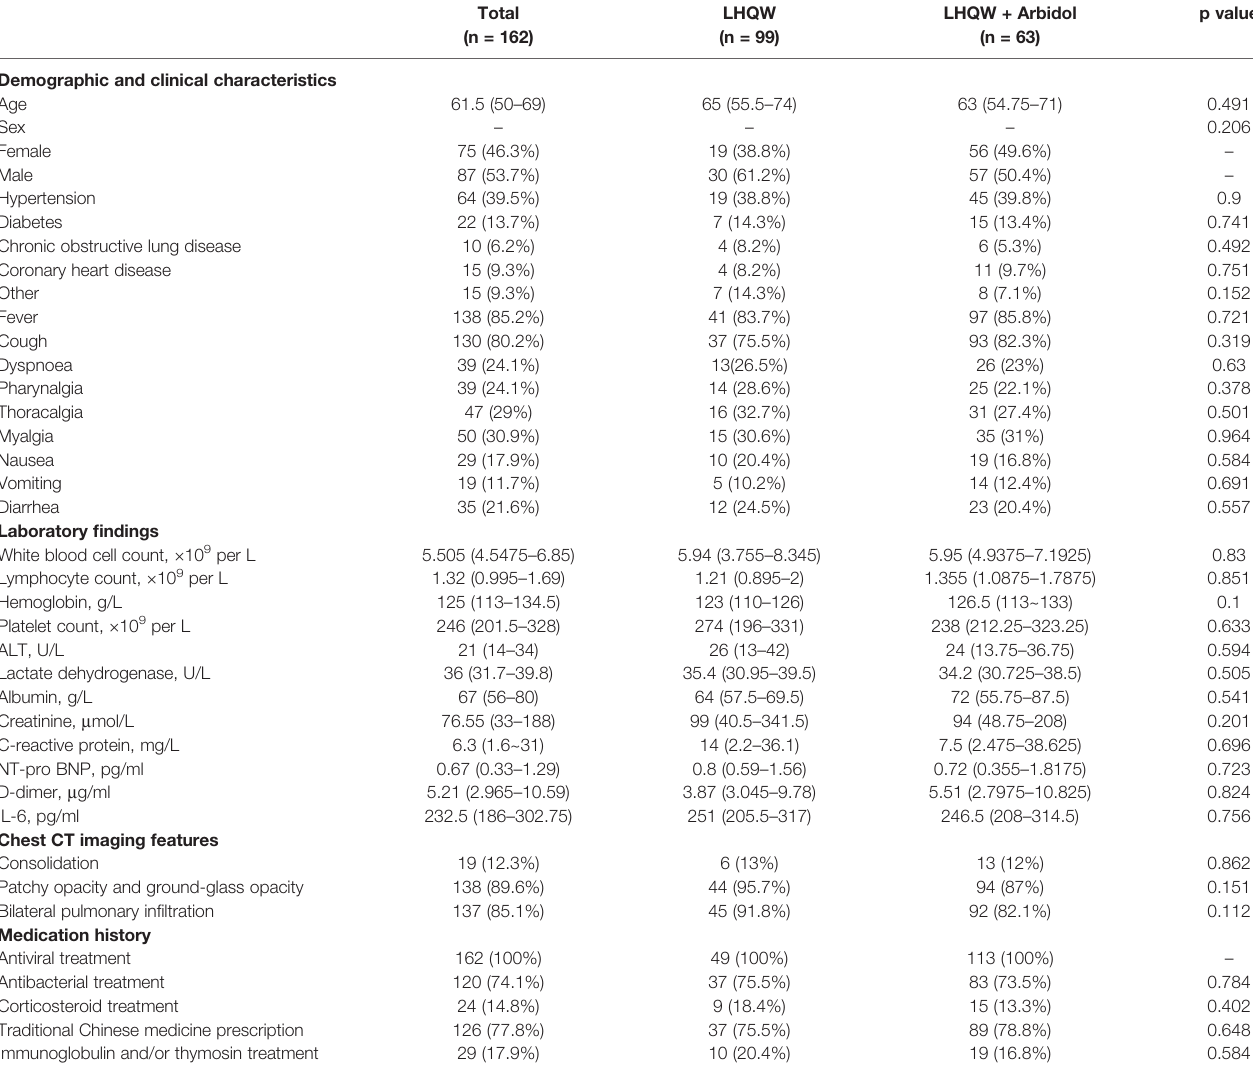
TABLE 1 | Demographic, clinical, laboratory, and radiographic characteristics and the medication history of all enrolled patients with